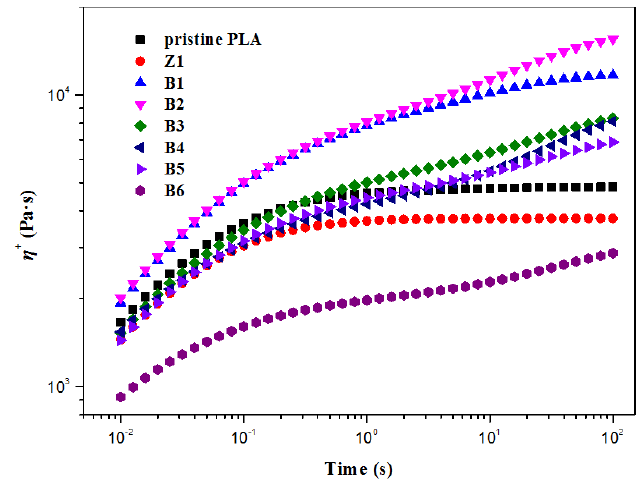
Figure 11. Tensile stress growth coefficients η + of PLA samples at a strain rate of 1.0 s − 1